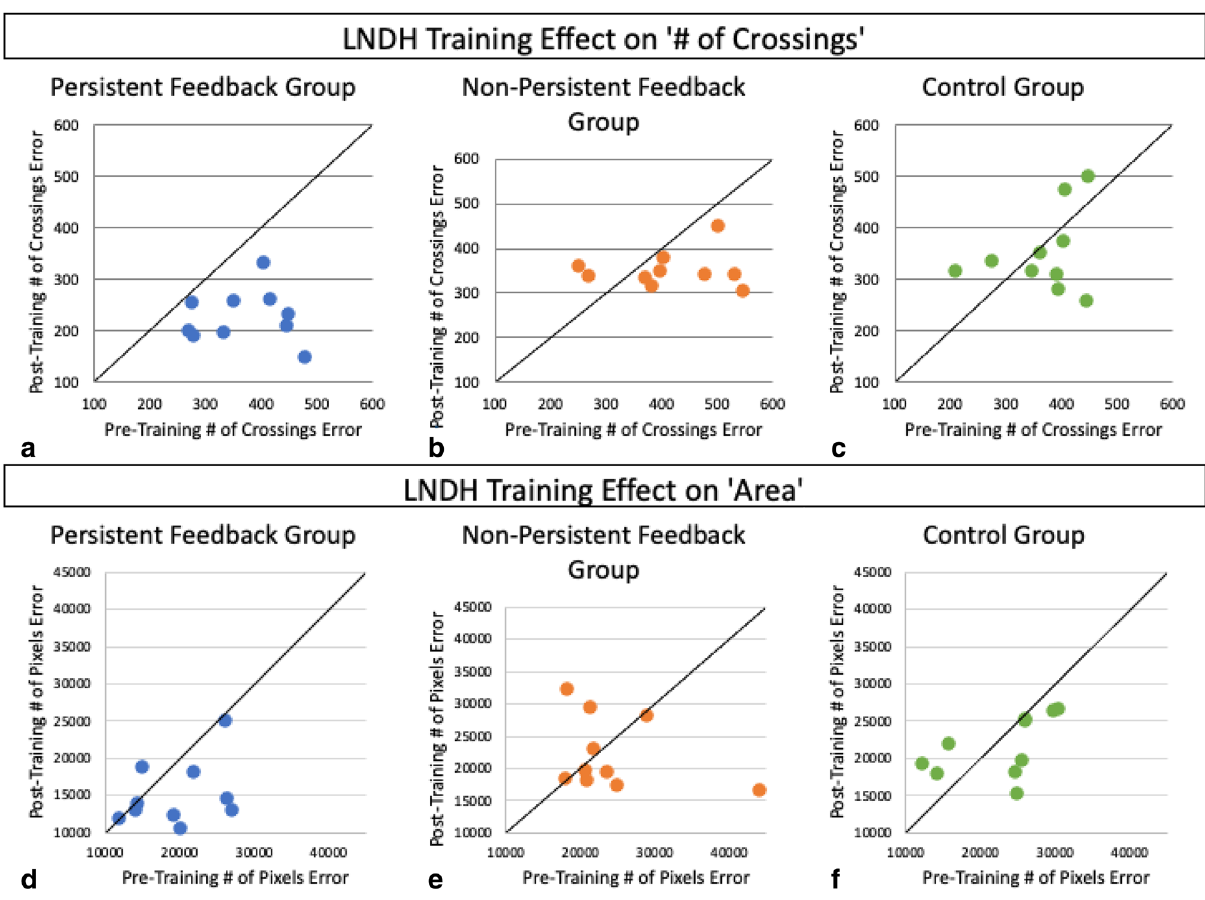
Figure 3. ‘Number of crossings’ error (top) and ‘area’ (bottom) scores are plotted to visualize post- (y-axis) versus pre- (x-axis) tracing scores for each subject, represented as individual points. Given that the metrics used represent errors, larger scores correspond to worse tracing performance. Thus, points that lie below on or above the diagonal indicate subjects with improved, unchanged, and worse post- versus pre-training tracing performance. Virtually every subject in the Persistent Feedback group shows improvement whereas subjects in the Non-persistent feedback and Control groups are more distributed, with more subjects exhibiting worse post- training accuracy than their pre-training